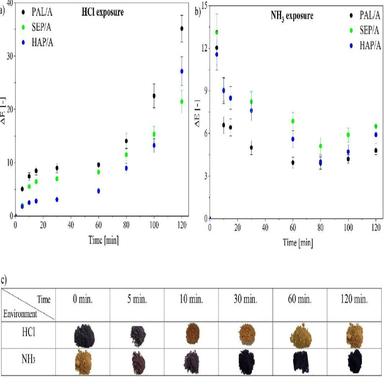
Total color change parameters (DE) for the prepared hybrid pigments during exposure to HCl (a) and NH3 (b) vapors and digital photographs of the PAL/A pigment powder.